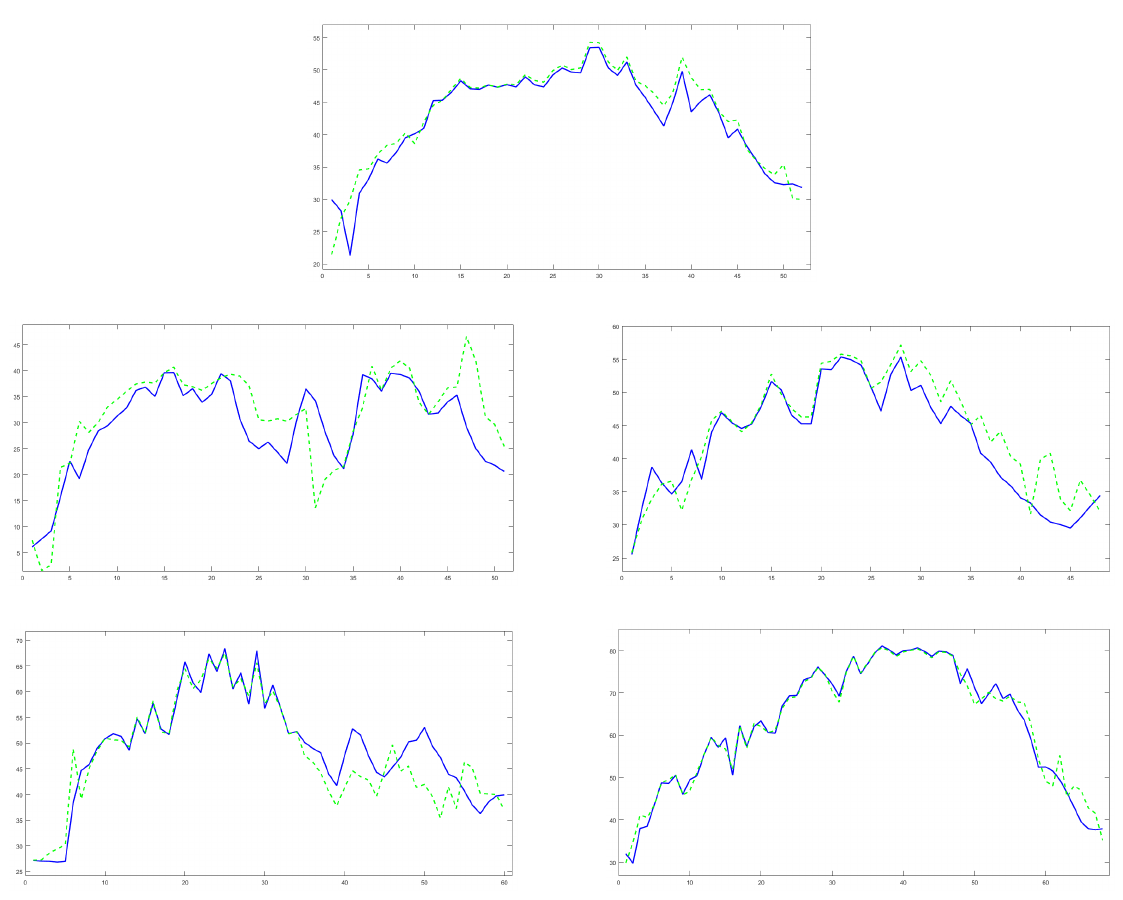
Figure 8. Validation days used to test the final hybrid